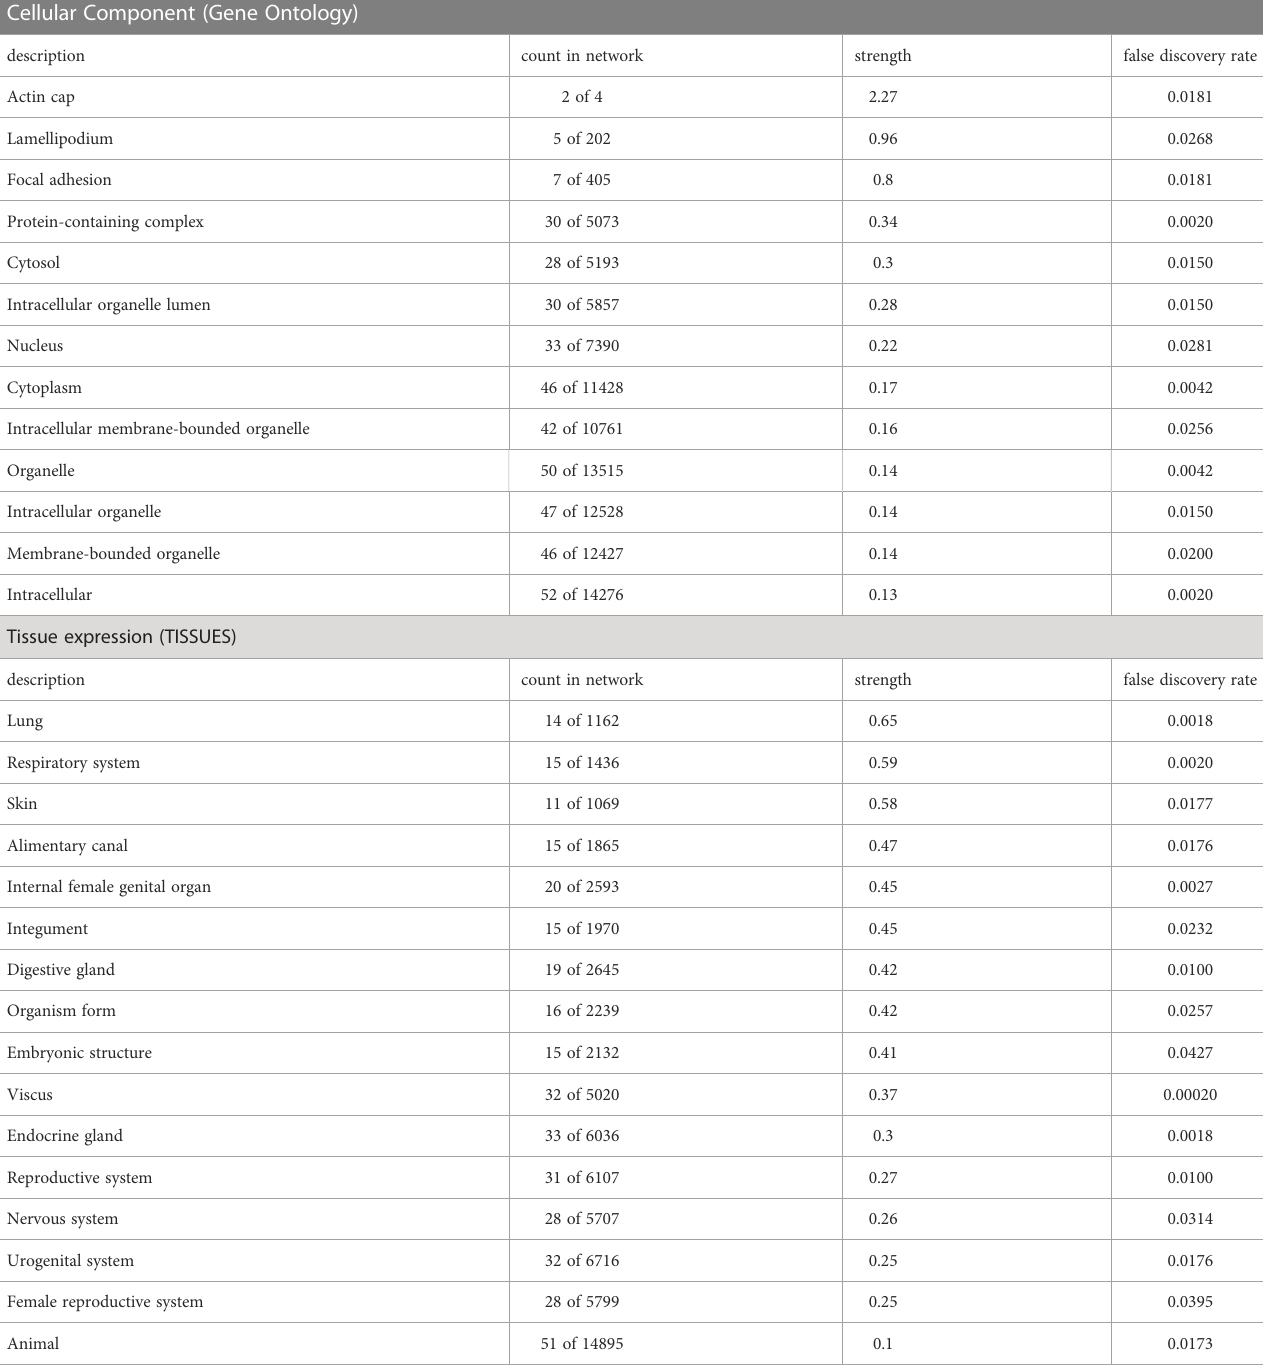
TABLE 1 String-DB (https://string-db.org/) functional enrichment analysis of cellular proteins with increased ubiquitination in the presence of Nef identi fi ed signi fi cant enrichment in 13 cellular components and 16 tissues, based on the 53 out of 93 proteins identi fi ed in the database. Cellular Component (Gene